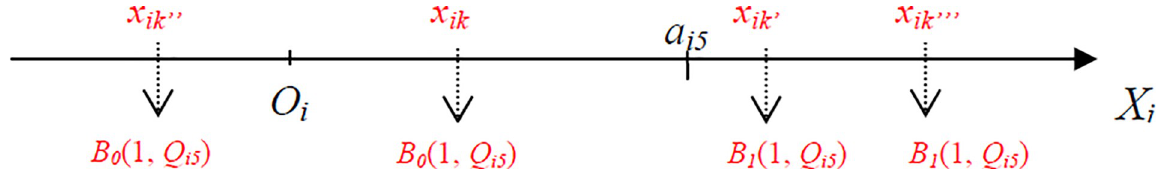
Fig 2. The g is from two Bernoulli random variables with same parameter but opposite meaning depending where the X ik a iz or � a iz